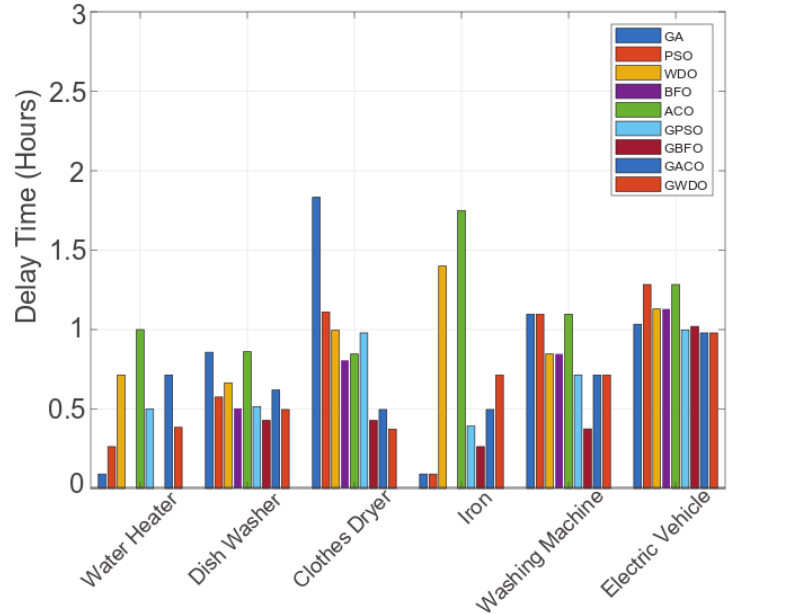
Figure 8. Case study 1: User comfort